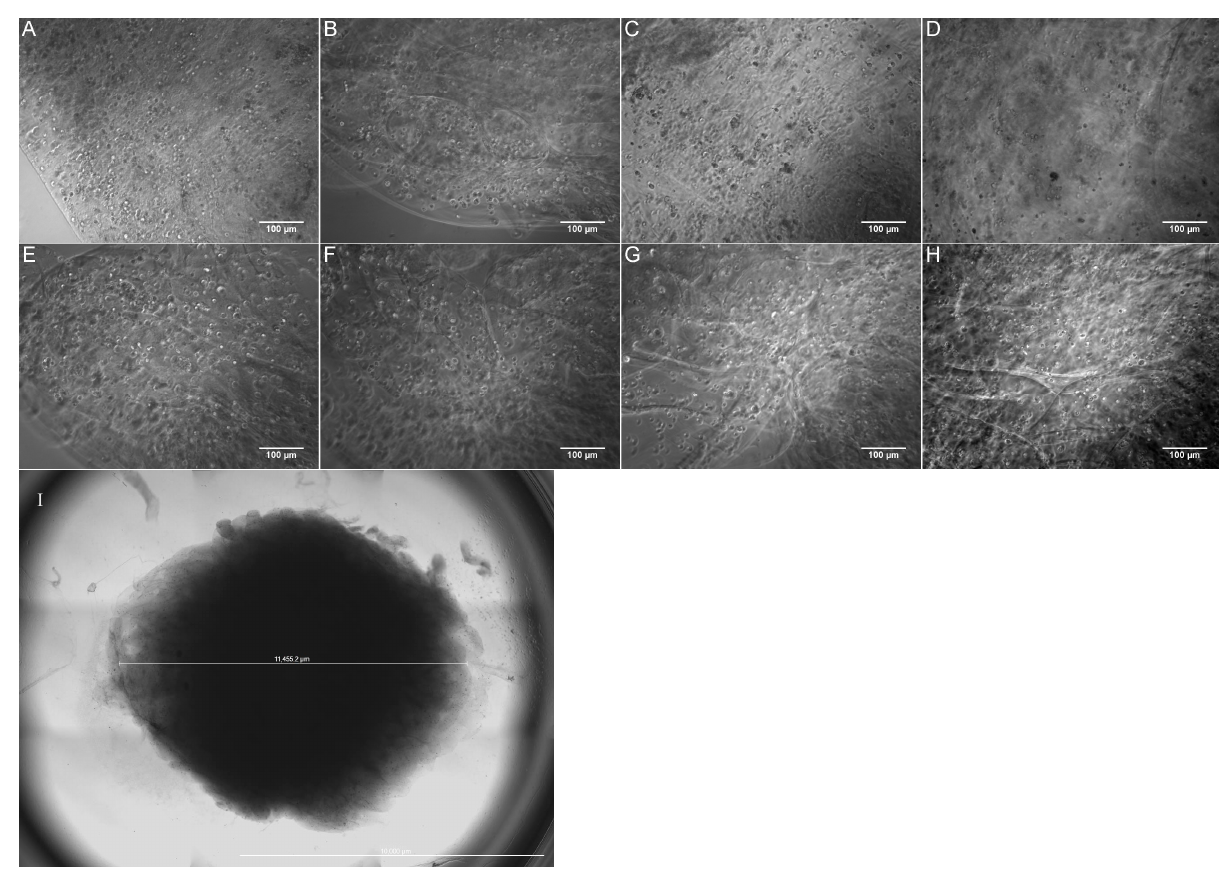
Figure 3. Phase contrast images of bioprinted half-spherical construct ( I ). Control group ( A – D ) and experimental group ( E – H ). Images were taken on day 0 ( A , E ), day 4 ( B , F ), day 9 ( C , G ) and day 12 ( D , H ). All images were taken at a single depth, representing one layer of the construct. Scale bar represents 100 µ m ( A – H ) and 10 mm ( I